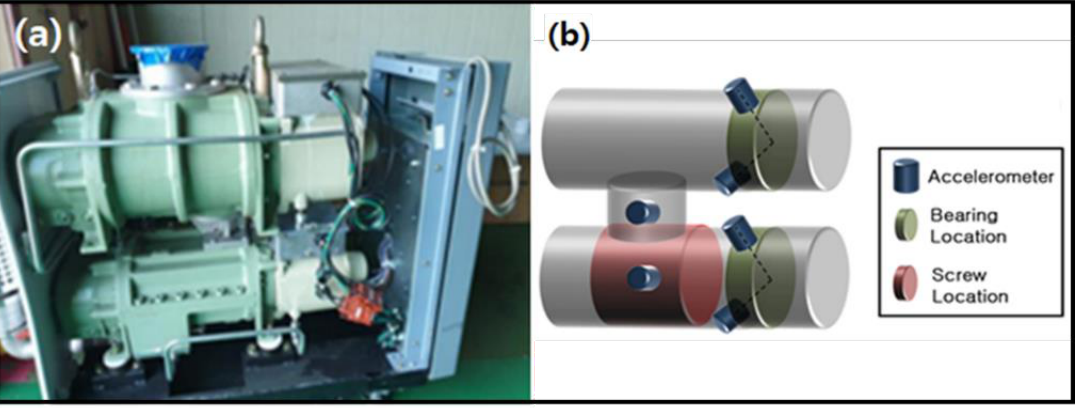
Figure 4. Set-up points of the accelerometer. ( a ) photograph of the pump (taken by the authors); ( b ) the set-up points of the accelerometers.